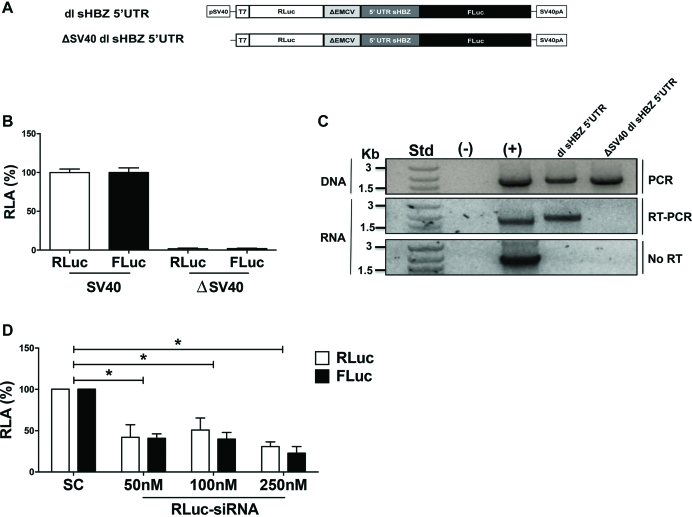
Cryptic promoter or splicing activity does not account for the FLuc activity. (A) Schematic representation of the bicistronic constructs. The SV40 promoter from dl sHBZ 5′UTR was removed to generate the promoterless (ΔSV40) vector. SV40pA represents the SV40 polyadenylation signal. COS-7 cells were co-transfected with plasmids containing the depicted reporters with the pcDNA3.1 lacZ plasmid. Total DNA, RNA and proteins were extracted from cells 24 h after transfection. (B) RLuc and FLuc activities were measured and normalized to the β-galactosidase activity. Values are expressed as RLA (%) relative to the RLuc and FLuc activities obtained from the dl sHBZ 5′UTR (with the SV40 promoter) plasmid, set to 100%. Values are the mean (+/− SEM) for three independent experiments, each performed in duplicate. (C) PCR was performed on total DNA isolated from the cells (top panel), while an RT-PCR was performed on total RNA. Primers that hybridized to the RLuc and the FLuc sequences were designed to detect the full-length bicistronic mRNA (middle panel). As an additional control, the one-step RT-PCR reaction was conducted in the absence of reverse transcriptase (No RT-PCR, bottom panel). The amplification reaction in absence of DNA or RNA was used as a negative control (−), while plasmid DNA was used as a positive control (+). (D) Approximately 50, 100 or 250 nM of scrambled control siRNA, or an siRNA that targeted the Renilla luciferase ORF, was co-transfected with the dl sHBZ 5′UTR plasmid. RLuc and FLuc activities were measured 24 h post-transfection and expressed relative to the scrambled control siRNA set to 100% (RLA). Values shown are the mean (+/− SEM) for three independent experiments, each performed in duplicate. Statistical analysis was performed by an ANOVA test followed by a Dunnett’s multiple test comparison (*P < 0.05).